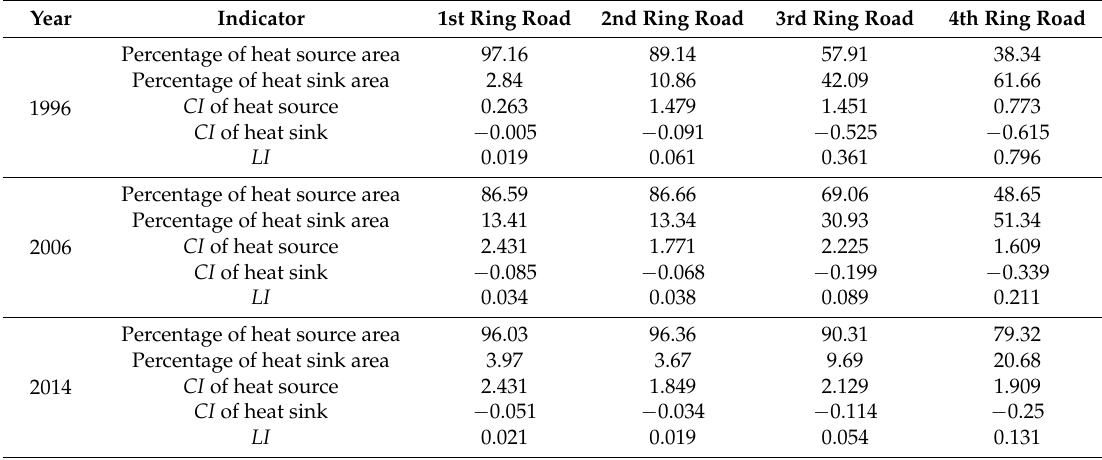
Table 6. The heat source and sink indices in different ring road areas of Zhengzhou City from 1996 to 2014.